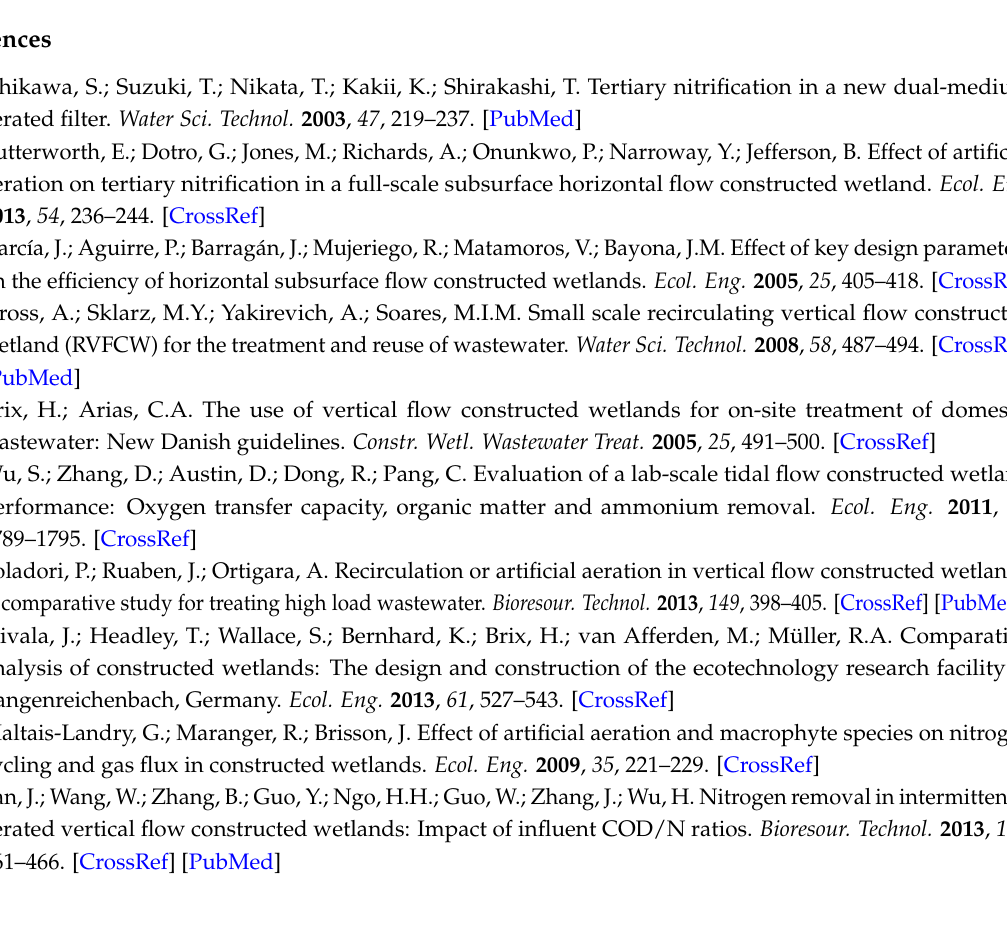
Figure S1: Ammonium loading and associated nitrification rates at Sites A–C; Figure S2: TSS loading and effluent concentrations at Sites A–C; Table S1: Inlet and outlet concentrations of BOD, TSS and NH 4+ -N at all